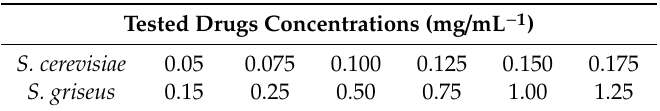
Table 1. Drug concentrations tested against S. cerevisiae and S. griseus